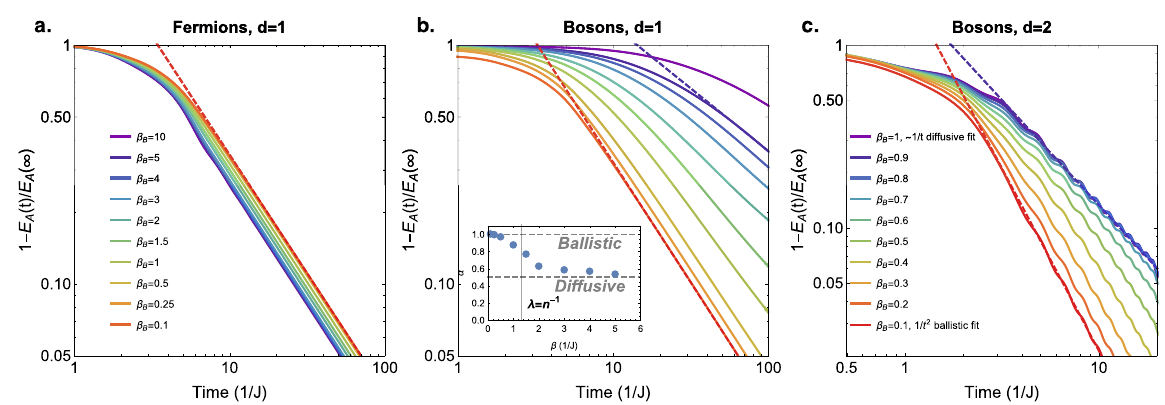
Figure 3. Decay of the energy difference between the system and the bath in non-relativistic fermionic or bosonic systems. In d = 1 (left two pictures) we have immersed a subsystem A at almost infinite temperature = 0.01 in a bath with varying temperatures β β A B . The chemical potential is tuned such that the particle density is n = 1/2, and the total system size is L = 200, and L A = 10. On the vertical axis we plot the energy density in subsystem A , E A ( t ), normalized by the energy density at infinite time E A ( t = ∞ ). In d = 2 (right picture) the subsystem A has size N A = 6 × 6 in a total system size of N = 48 × 48. ( a ) In fermionic systems, the decay is always of a ballistic nature, Δ E ~ t − d . ( b ) In bosonic systems, there is a crossover from ballistic t − d to diffusive t − d /2 decay. We fit the long-time behavior with the power-law form t − α . The inset shows the power α as a function of inverse bath temperature β B . The crossover from ballistic to diffusive occurs around the point β λ is comparable to the interparticle spacing n − 1 , suggesting the c ~ 1.3 where the thermal de Broglie wavelength wave-like nature of the bosons is responsible for the diffusive behavior. ( c) The crossover can also be observed in d = 2 dimensions. The crossover occurs at higher temperatures, since the value where λ ~ n − 1/2 has shifted to higher temperature, β c ~ 0.8. Small oscillations with period 1/4 J can be observed due to the specific choice of lattice